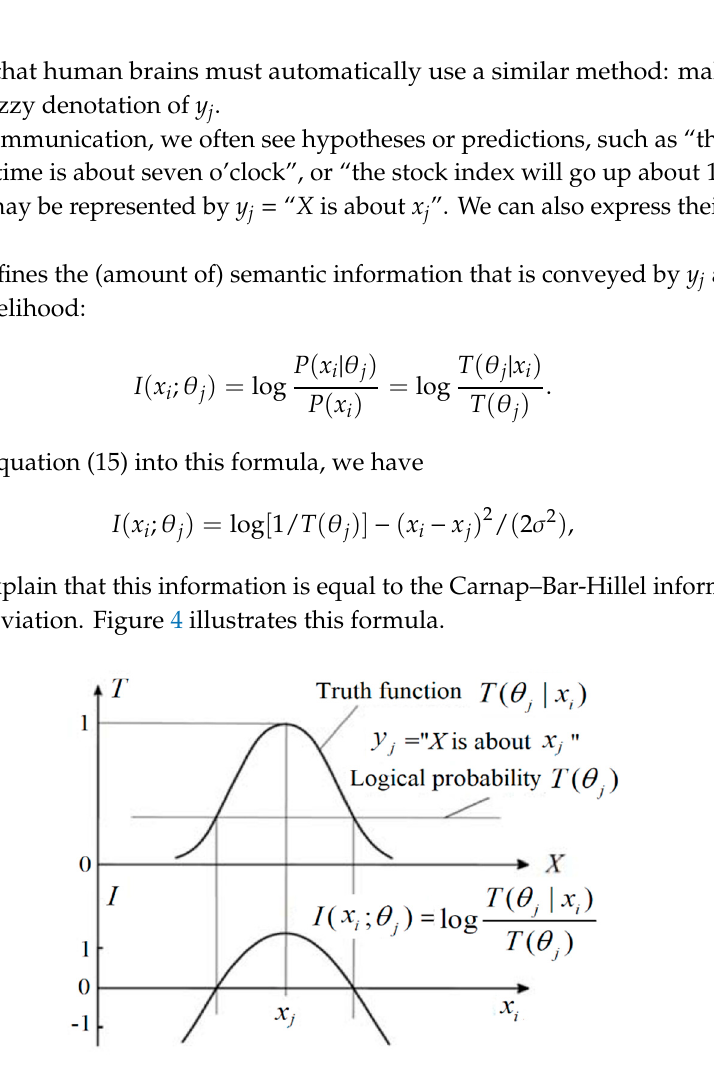
Figure 4. The semantic information conveyed by y j about x i .